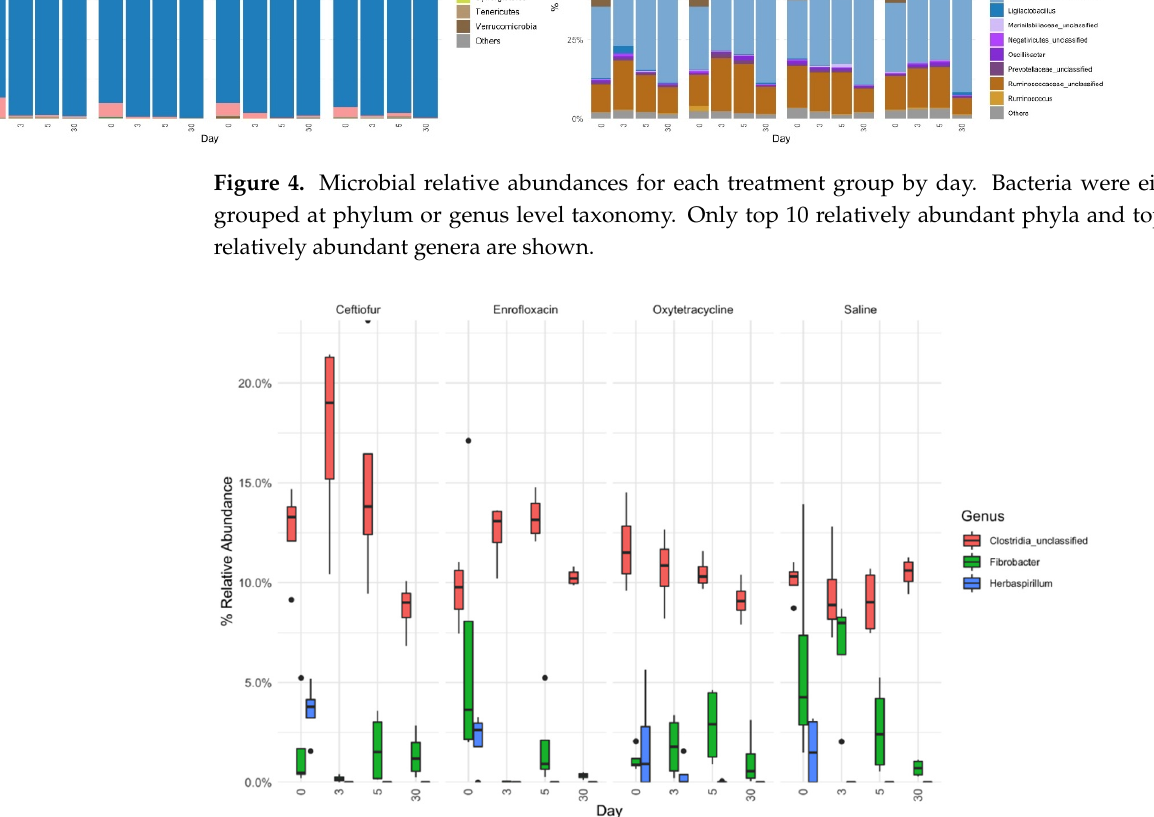
Figure 5. Boxplot relative abundances of three genera throughout treatment duration. Data presented as median and interquartile range (IQR). Whiskers are 1.5 × IQR and data outside the whiskers are shown as outliers (black circles). Relative abundances are shown for Fibrobacter , Herbaspirillum and unclassified Clostridia. Clostridia_unclassified represents cumulative relative abundance of Clostridia_unclassified, Clostridiales_Incertae_Sedis_XIII_unclassified and Clostridiales_unclassfied as displayed in Figure 4.